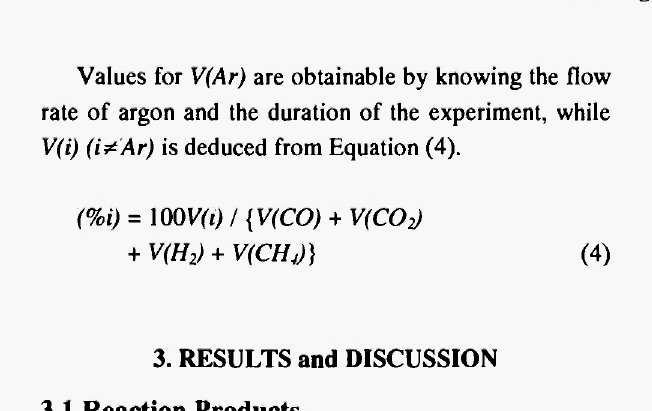
Experimental results for polyethylene.